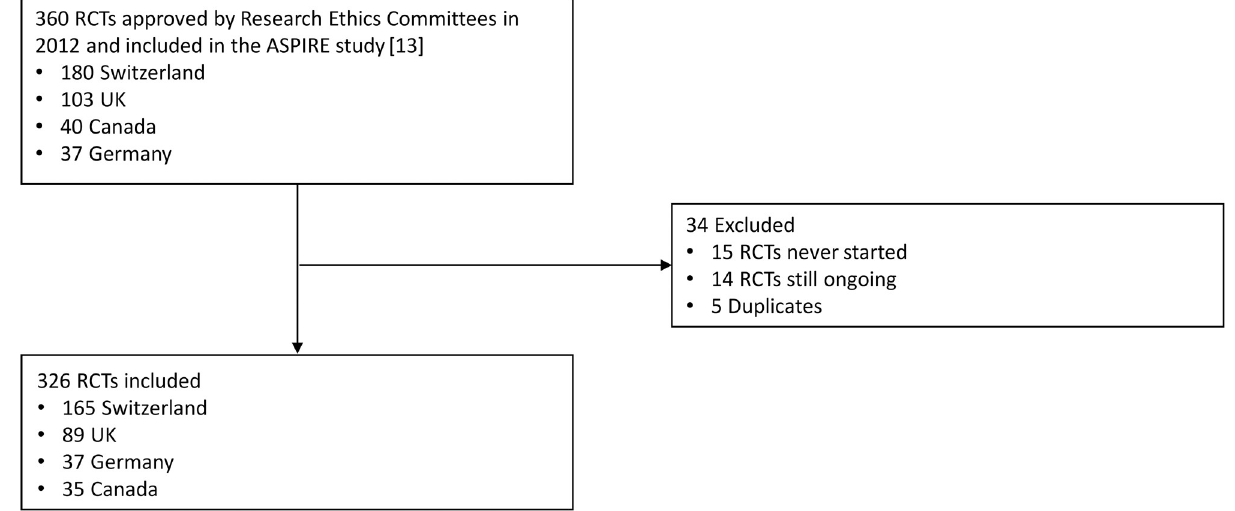
Fig 1. Flow chart. ASPIRE, Adherence to SPIrit REcommendations; RCT, randomized clinical